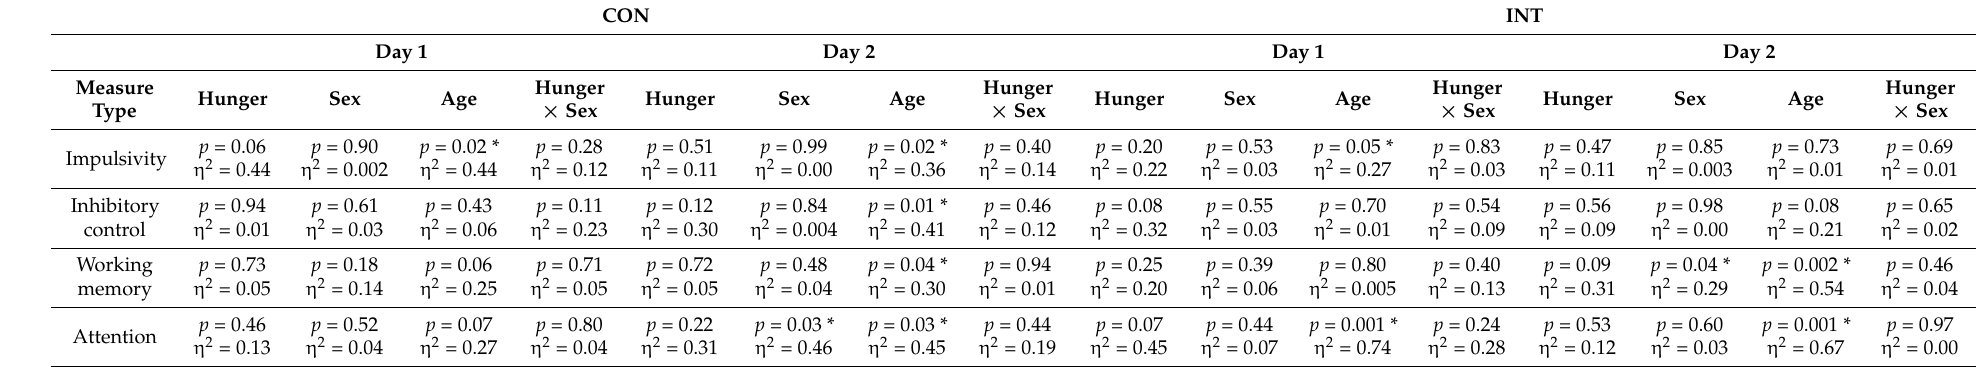
Table 5. One-way ANOVA: hunger ratings vs. learning